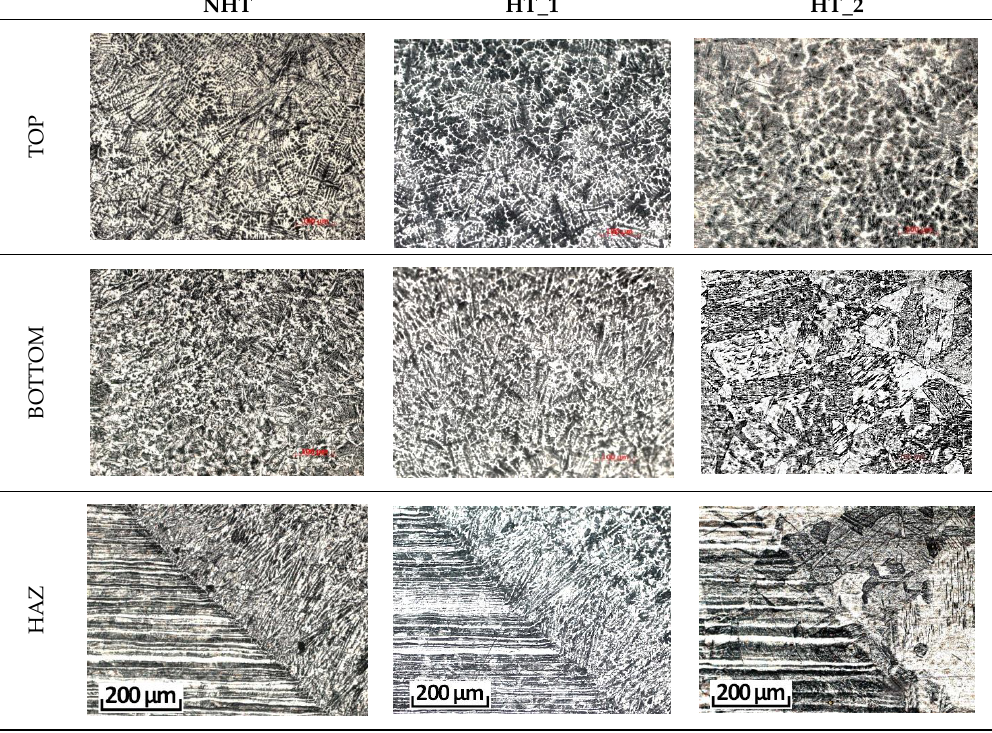
F2 Figure 2. Cross-sections (Top, Bottom, HAZ) at a magnification of 200 times. BM, base metal; HAZ, heat affected zone.